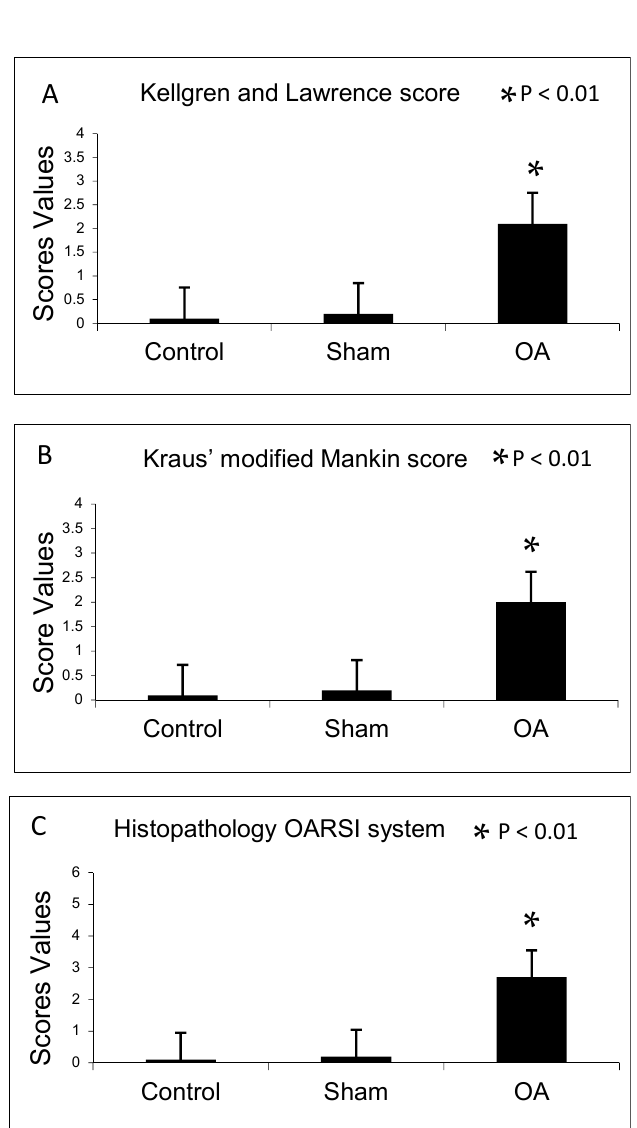
Figure 1. ( A ) Kellgren and Lawrence score among groups; ( B ) Kraus’ modified Mankin score among groups; and ( C ) Histopathology Osteoarthritis Research Society International (OARSI) system among groups. Results are presented as the mean ± SEM. Analysis Of Variance (ANOVA), was used to evaluate the significance of the results. * p < 0.01, when compared to the control groups. OA: Osteoarthritis.